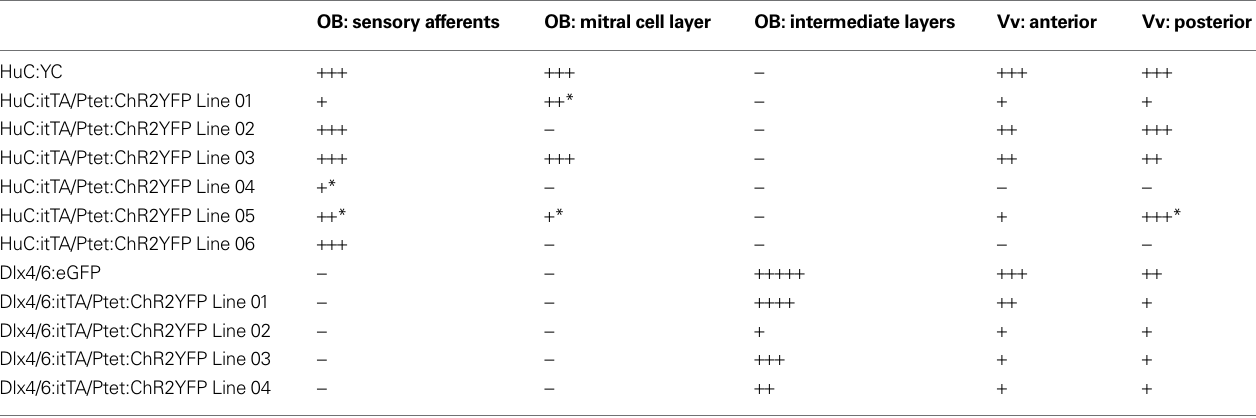
Table 1 | Summary of expression patterns in different transgenic lines.